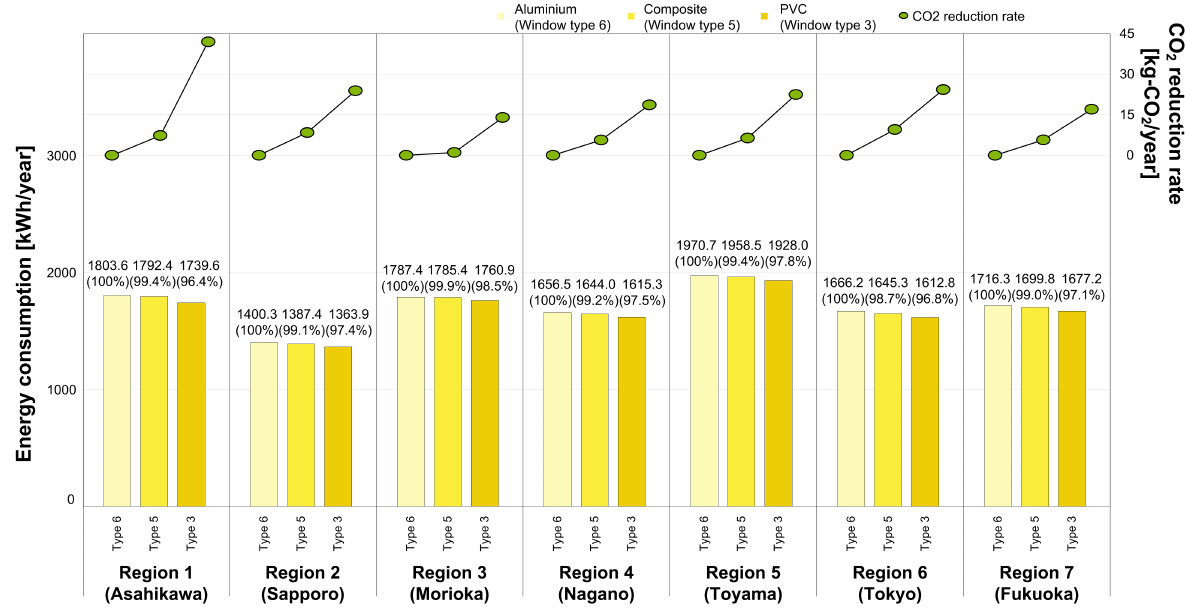
Figure 4. Annual energy consumption and CO 2 reduction rate of window frame according to region. PVC, polyvinyl